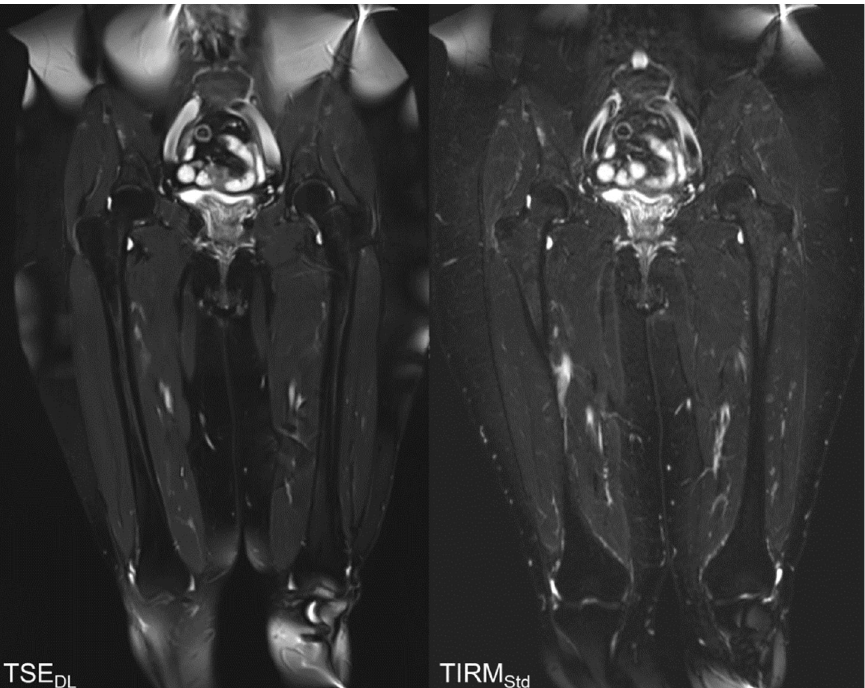
Figure 4. Follow-up MRI examination of an 81-year-old patient with Merkel cell carcinoma. As an incidental finding, the coronal TIRM Std sequence shows a lipoma of the medial vastus muscle. The T2w TSE DL shows a better image quality, noise, and sharpness than the TIRM Std .